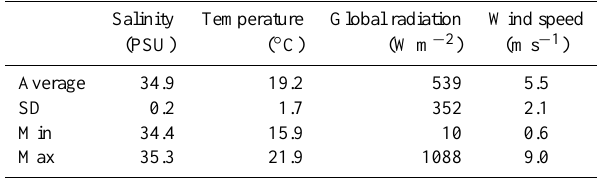
Table 1. Data on average, maximum and minimum salinity, wa- ter temperature, global radiation and wind speed during M91. Data were retrieved from Dship data server of R/V Meteor .